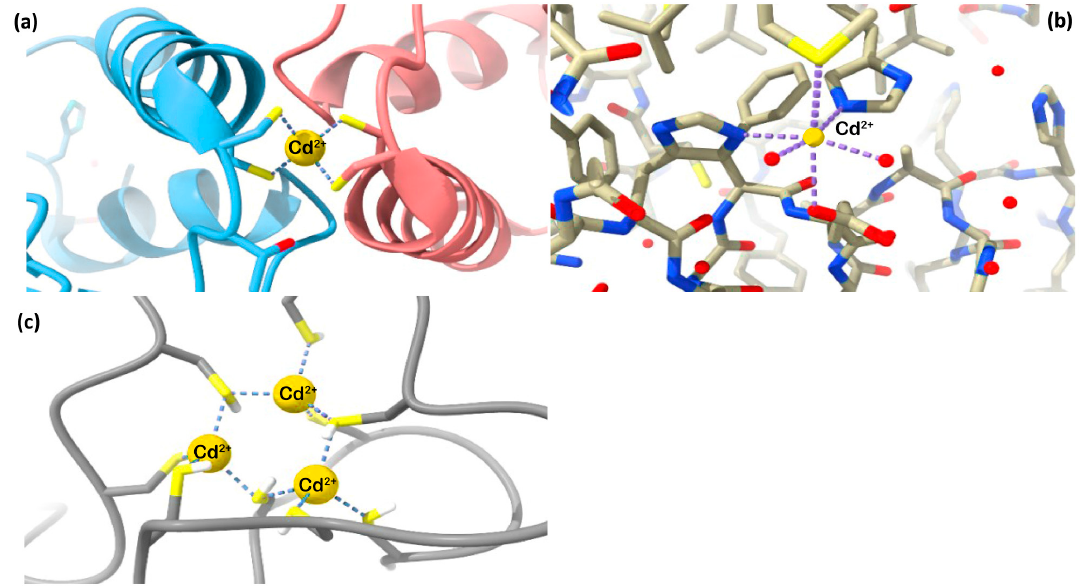
Figure 1. Examples of Cd 2+ coordination environment in biological systems: ( a ) regular tetrahedral Cd 2+ complexed with Hah1 metallochaperone protein (Protein Data Bank PDB 1FE0, [21] ); ( b ) regular octahedral Cd 2+ complexed with cytochrome c oxidase (PDB 2EIK, [22] ); ( c ) a cluster of Cd 2+ complexed with metallothionein-1 (PDB 1DFT, [23] ).